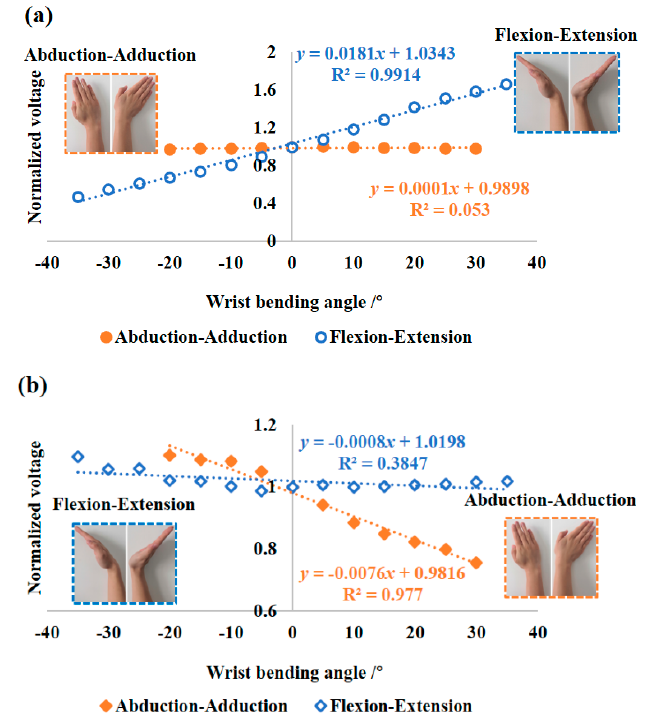
Figure 5. The measured responses to wrist flexion-extension and abduction-adduction movements for ( a ) the side-polished POF and ( b ) the etched grating POF.